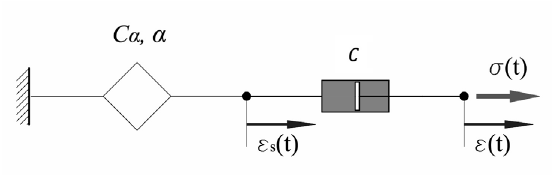
Fig. 3. Springpot element in series with a